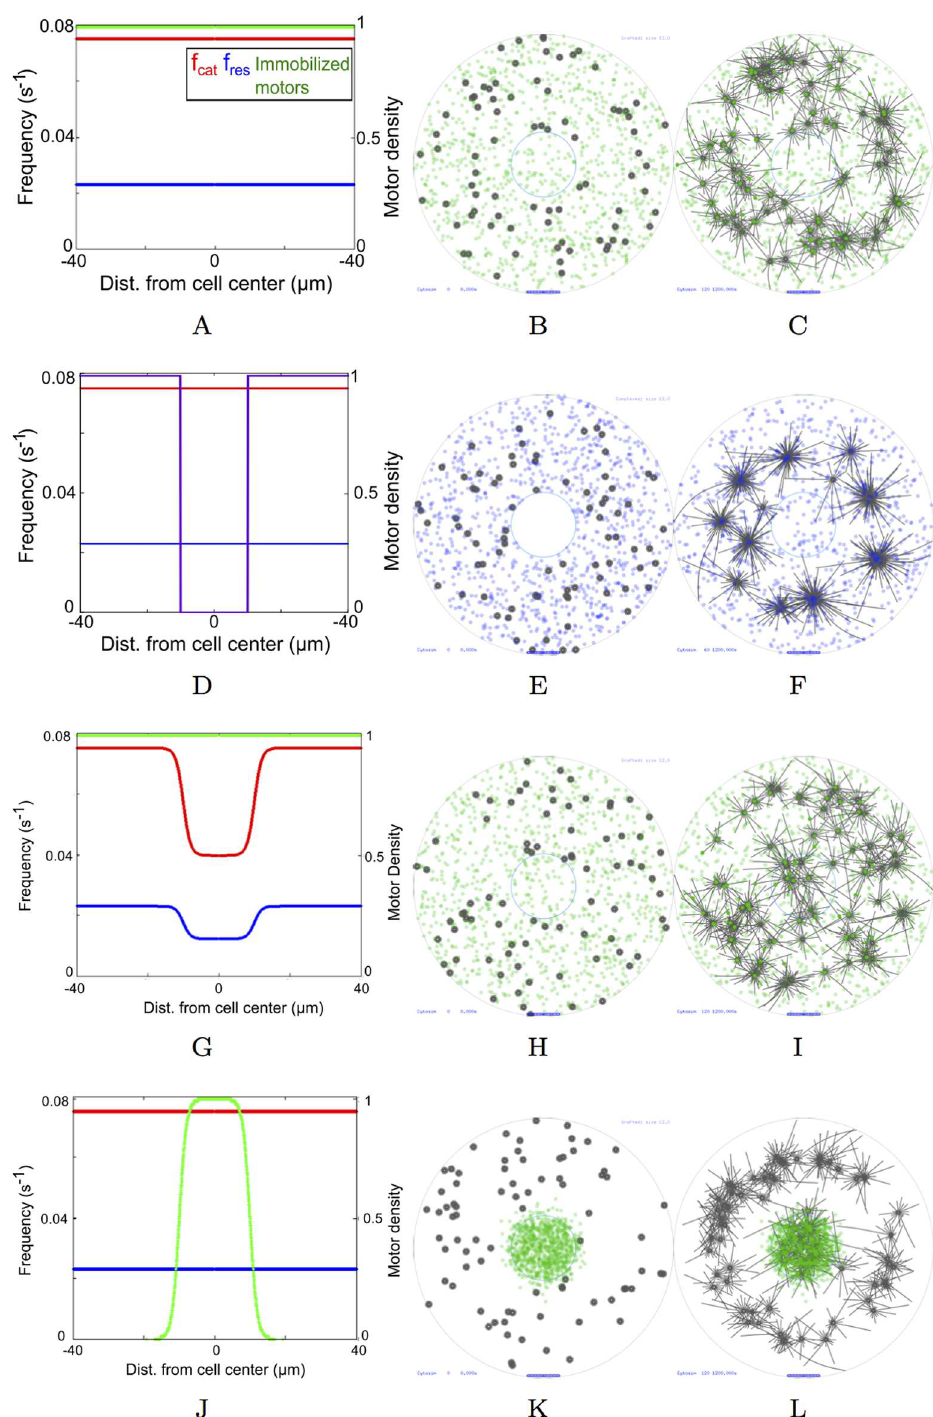
Fig 3. MT-motor model scenarios. ( Left column ) The distributions of f cat (red), f res (blue) and motor density of immobilized minus-ended motors (green) and (at t = 0) diffusible minus-ended motor complexes (purple) are plotted as a function of radial distance from the oocyte center. ( Middlecolumn ) Simulationoutput at t = 0 minutes and ( Right column ) t = 20 minutes with MTOCs (grey) and a concentric nucleus (blue circle) with immobilized minus-ended motors (green dots) and diffusible tetrameric motor complexes (purple dots). Scenarios simulated: (A, B, C) Uniform distribution of f cat and f res and surface-immobilizedmotors N i